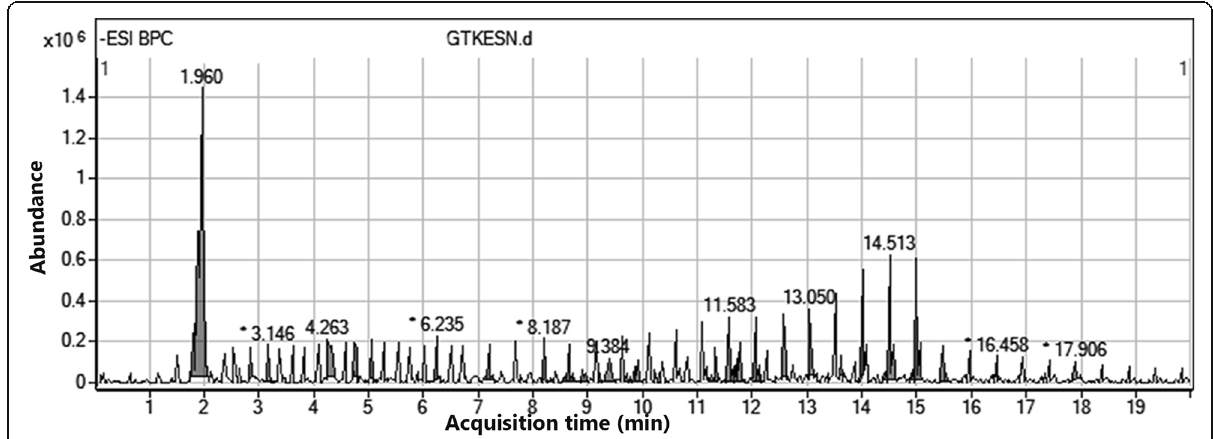
Fig. 1 ESI-MS-base peak chromatogram of GTK in negative ionization